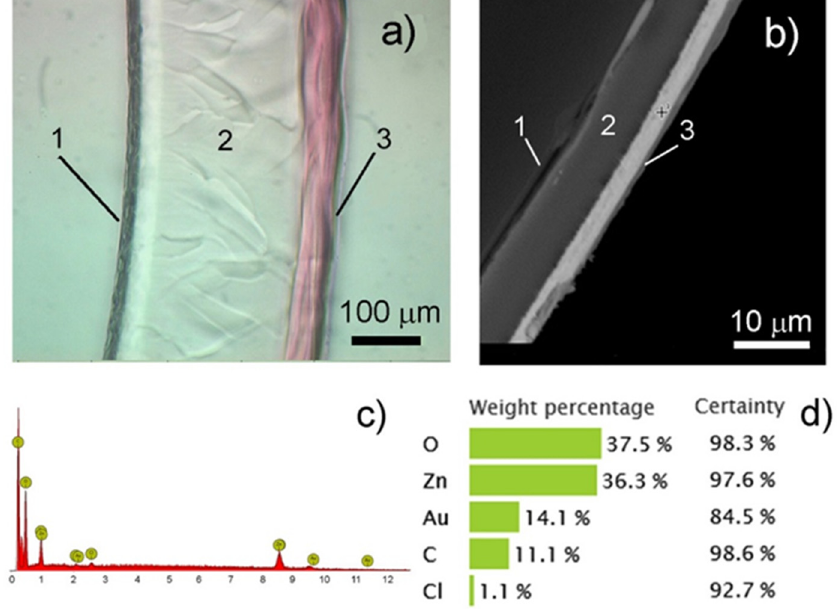
Figure 11. Cross section ( a , b ) and elemental composition ( c , d ) of the PMAA/AuNPs composite film. Electrolyte 3. Swollen state ( a ), dry state ( b ). Optical microscope Axioplan 2 Imaging, Carl Zeiss with a photographic attachment Panasonic NV-GS330EE-S and electron microscope PHENOM pro-X.